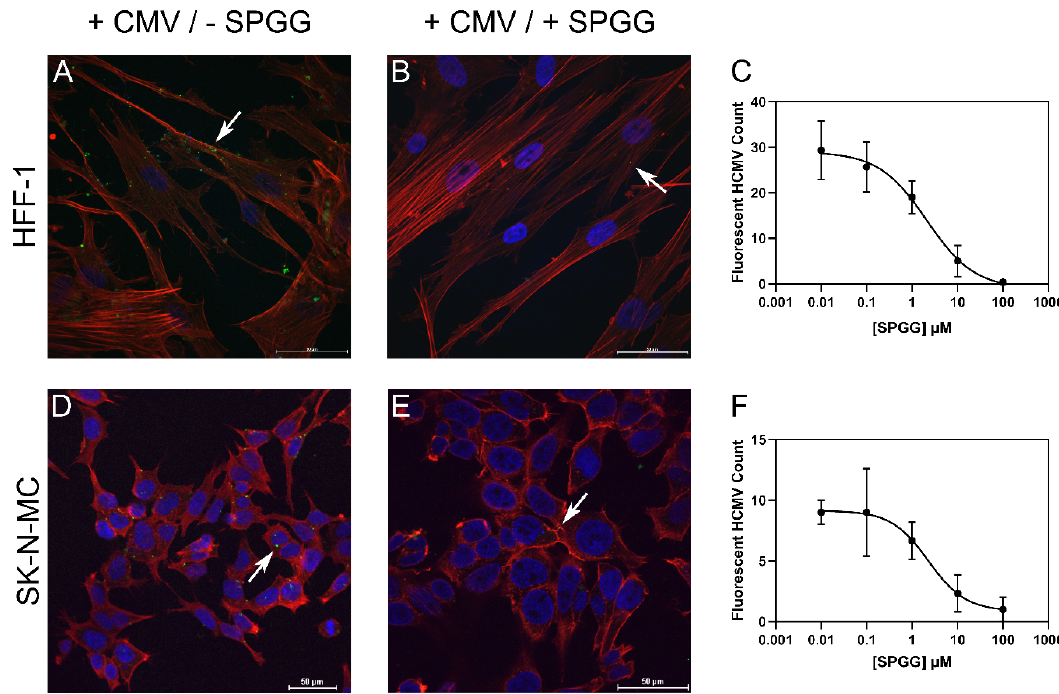
Figure 3. Human cytomegalovirus (HCMV) entry into HFF-1 and SK-N-MC cells treated with SPGG in High-resolution confocal microscopy. HFF-1 and SK-N-MC cells were challenged with the HCMV strain BAD32GFP which was pre-incubated with or without SPGG 100µM for 1 h. The double immunolabeling in confocal microscopy shows an increased number of GFP puncta (green highlighted with white arrows) in HFF-1 cells ( A ) and SK-N-MC cell ( D ) infected with HCMV and mock-treated compared to HCMV treated with SPGG ( B , E ). Cells were counterstained with phalloidin (red) and DAPI (blue) and images were processed and enumerated using ImageJ. The number of GFP-positive puncta detected in HFF-1 ( C ) and SK-N-MC ( F ) cells infected with HCMV exposed to different concentrations of SPGG was quantified in ImageJ using 3 random views per slide. The Graphs show a clear dose-dependent reduction in number of GFP-positive for both cell lines. Data are shown as mean value and SD for a triplicate experiment. Scale bar ( A – E ) = 50 µm.